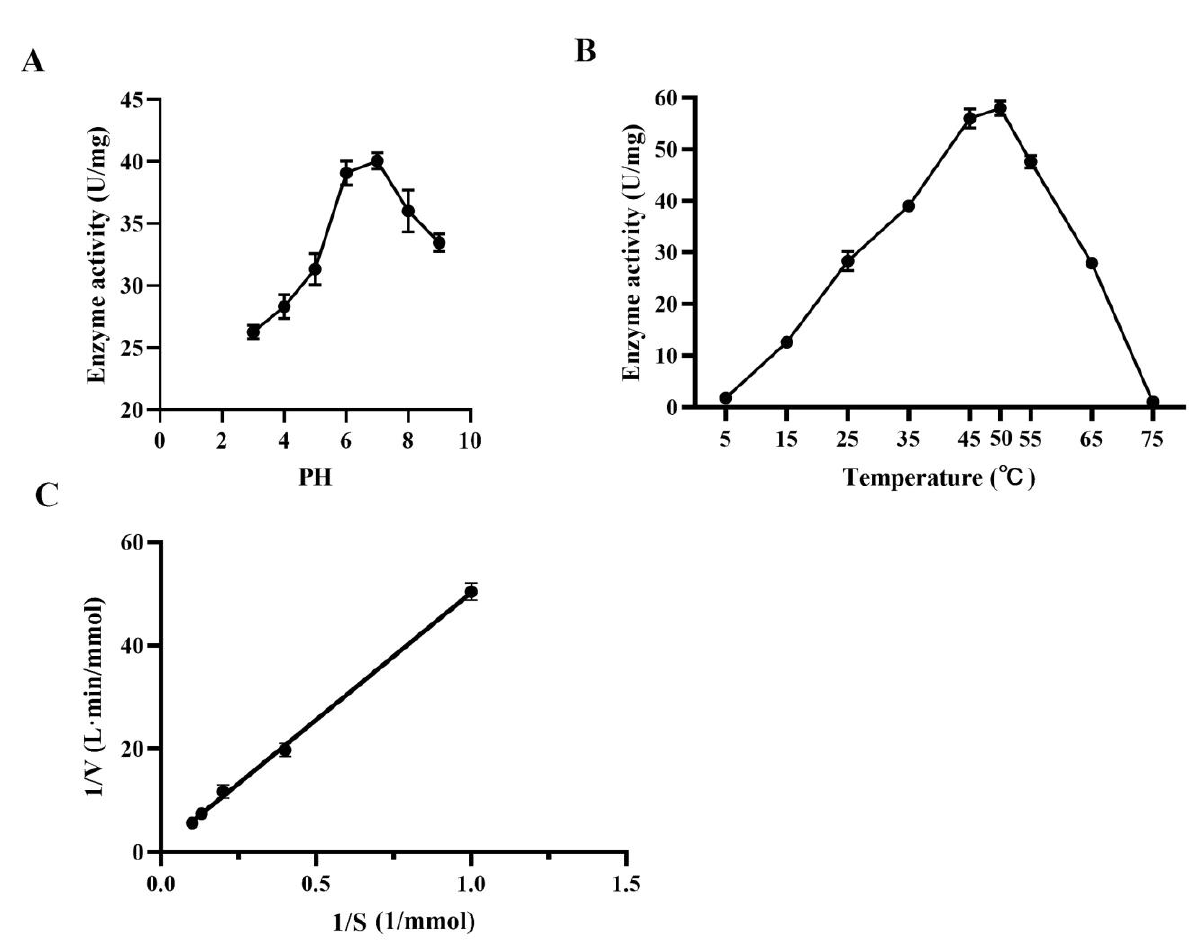
Figure 9. Enzymatic properties of the LoTRE1 recombinant protein. ( A ) Enzyme activity of trehalose under different pH conditions. ( B ) Enzyme activity of trehalose under different temperature condi- tions. ( C ) Steady state kinetic equation of LoTRE1 .